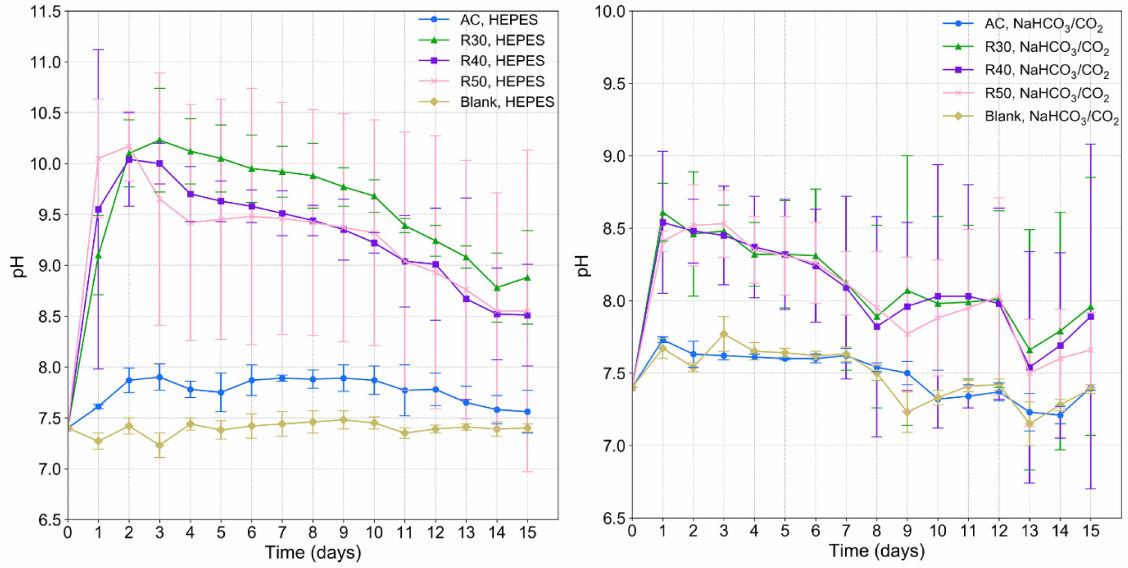
Figure 8. Average pH of EBSS as a function of the immersion time and buffer system for AC and RX samples buffered with HEPES ( left ) and NaHCO 3 /CO 2 ( right ). The pH stability of the buffered EBSS systems without immersed samples was also verified